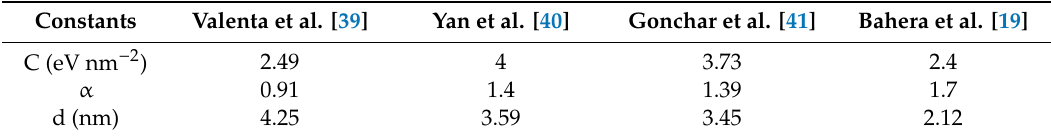
Table 1. Comparison of the SiNCs sizes value estimated from Equation (10) for di ff erent reports of the literature. Constants Valenta et al. [39] Yan et al. [40] Gonchar et al. [41] Bahera et al.